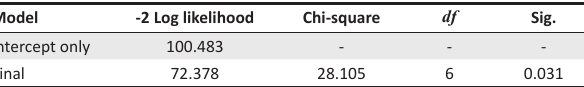
TABLE 3: Goodness of fit test. Model